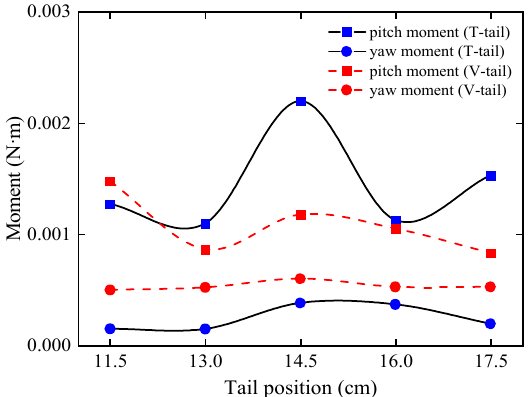
Figure 18. The relationship between tail position and control moment. The farther the tail position, the smaller the degree of undulation of the control moment was, so the unsteady effect became weaker. The pitch moment time-history of the inverted T-tail in different tail positions is shown in Figure 19. When the tail position was located at 17.5 cm, the mean value of the moment was larger, and the fluctuation of the moment was relative minimum. When the tail position was located at 11.5 cm, it was strongly disturbed by the flapping wing, and the variation of the moment within the period was the largest. As the tails moved away from the flapping wing, the phase of the peak moment also shifted back.